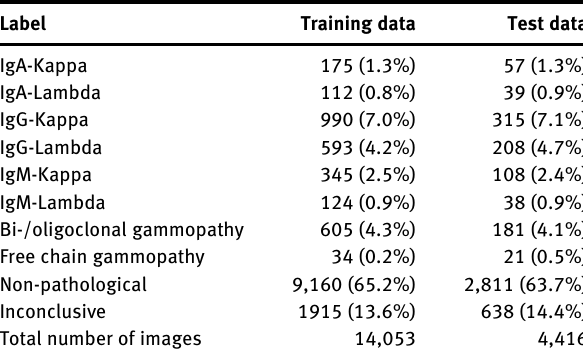
Table  : Label distribution of the datasets for training and testing.